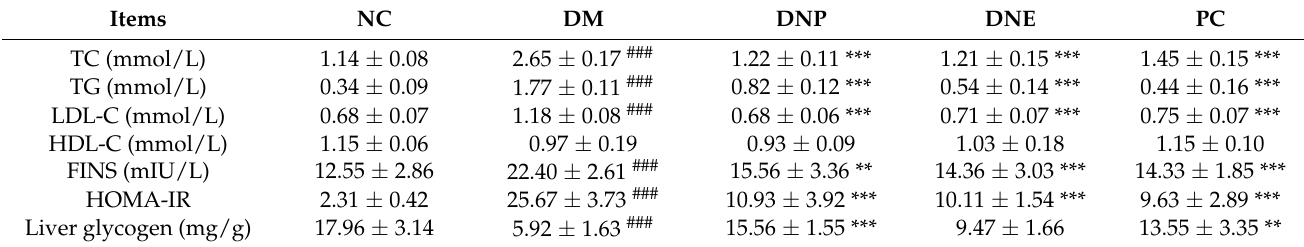
Table 3. Effect of D. nobile on serum lipid profile, insulin level and liver glycogen of rats.